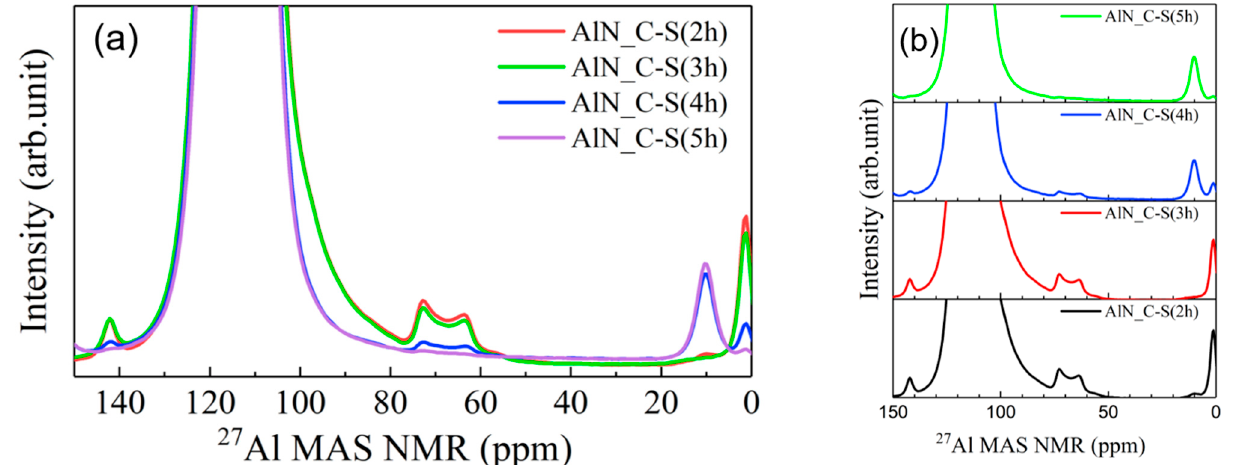
Figure 4. ( a ) Al solid-state NMR spectra for sintered samples (AlN_C-S materials with carbothermal reaction time of 2–5 h). After sintering, the peaks due to AlN 3 O defect (~110 ppm) near main peak (AlN 4 ) were removed, as shown in Table 1. ( b ) As carbothermal reaction time increases (decreasing oxygen concentration), peaks due to AlNO 3 defect of intermediate γ -AlON (60–70 ppm) decrease with increasing peak intensity due to AlO 6 defect (~10 ppm).